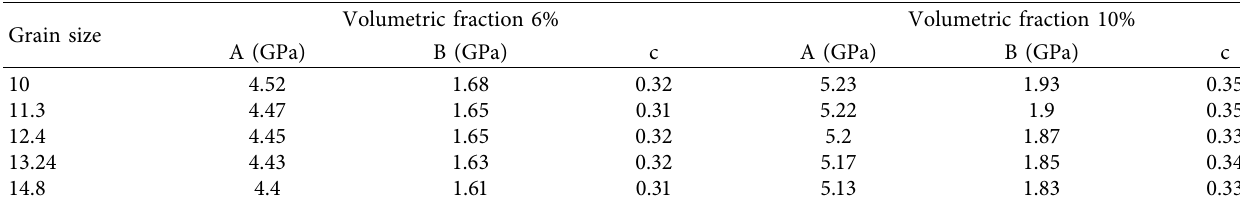
Table 1: Mechanical parameters of composite materials.